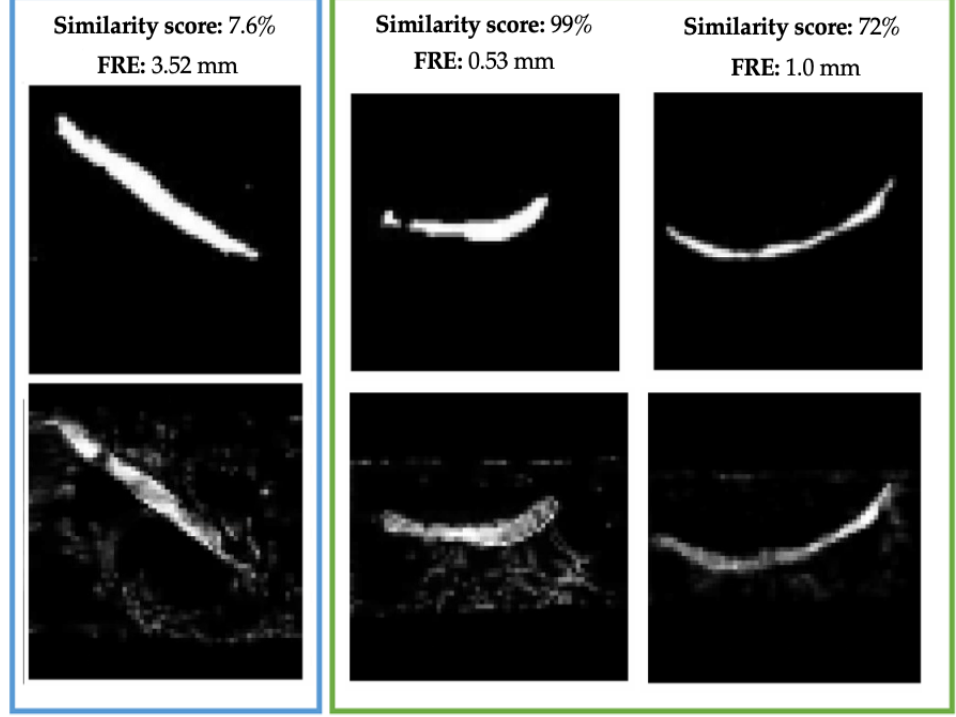
Figure 15. Registered pairs and their corresponding FRE and similarity score from the test set in the first fold. FRE is demonstrated in mm.